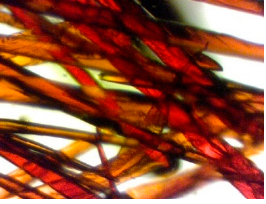
Figure 6. Microphotograph of crystalline 3 .